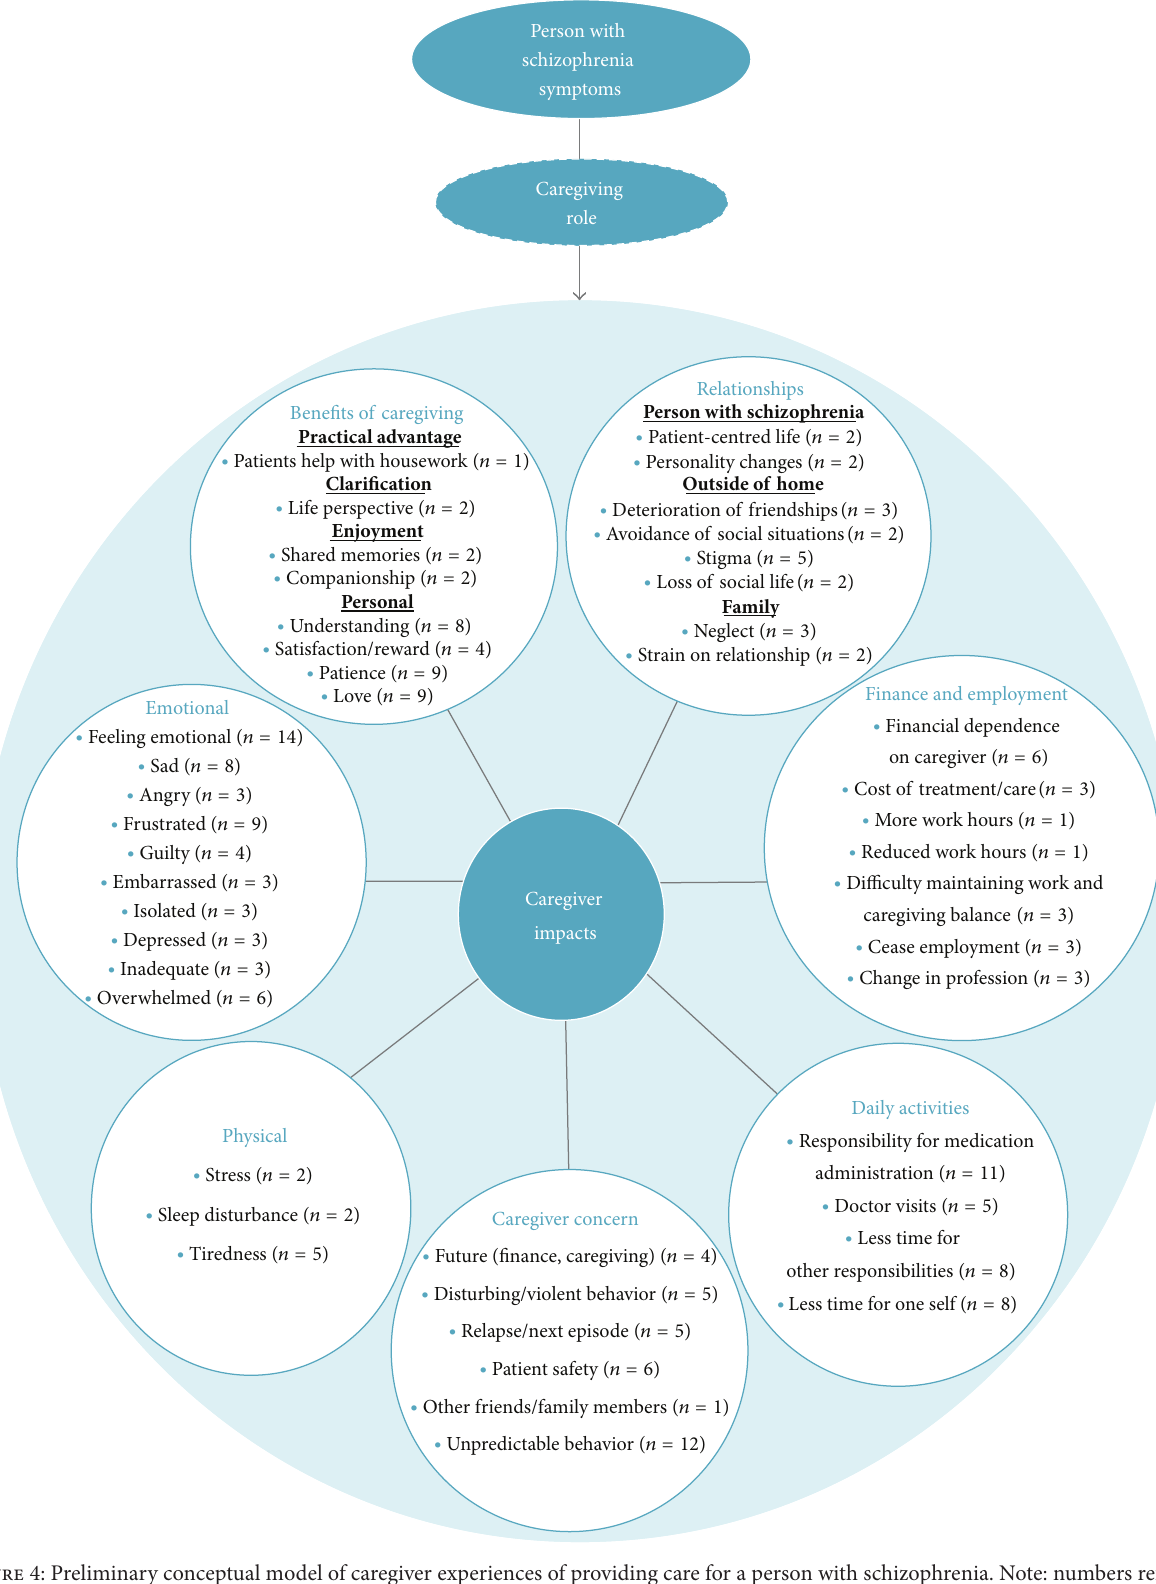
Figure 4: Preliminary conceptual model of caregiver experiences of providing care for a person with schizophrenia. Note: numbers refer to the number of caregivers who discussed each concept and for whom this concept was relevant. This preliminary conceptual model does not seek to convey the strength, direction, or nature of relationships between concepts and domains. This is to be the subject of future